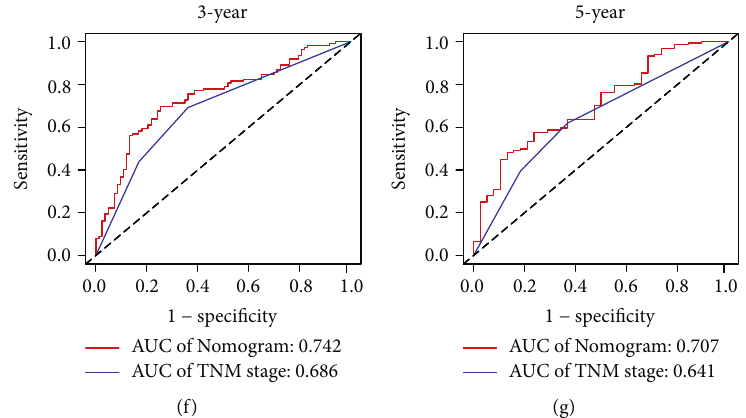
Figure 8: Construction and evaluation of the nomogram for predicting the OS of HCC patients. (a) Nomogram for predicting 1 year, 3 years, and 5 years OS. (b – d) Calibration plots of the nomogram for predicting OS at 1 year (b), 3 years (c), and 5 years (d). (e – g) ROC curves of the nomogram and TNM stage at 1 year ( AUC = 0 : 715, 0 : 655 , respectively, e), 3 years ( AUC = 0 : 742, 0 : 686 , respectively, f), and 5 years ( AUC = 0 : 707, 0 : 641 , respectively,